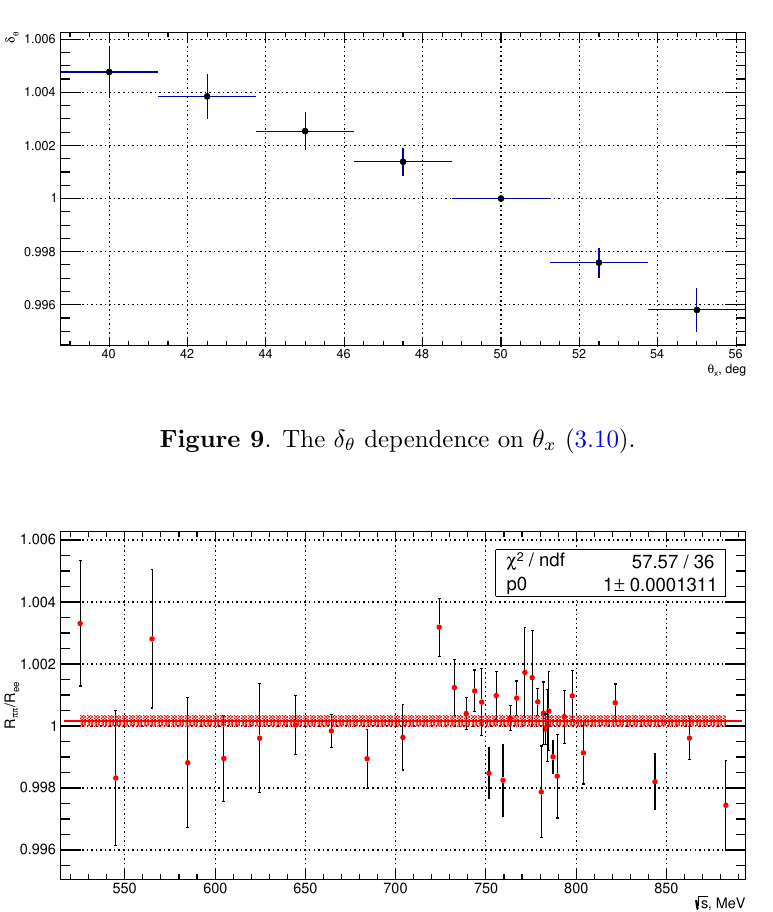
Figure 10 . The R (cid:25)(cid:25) =R ee dependence on